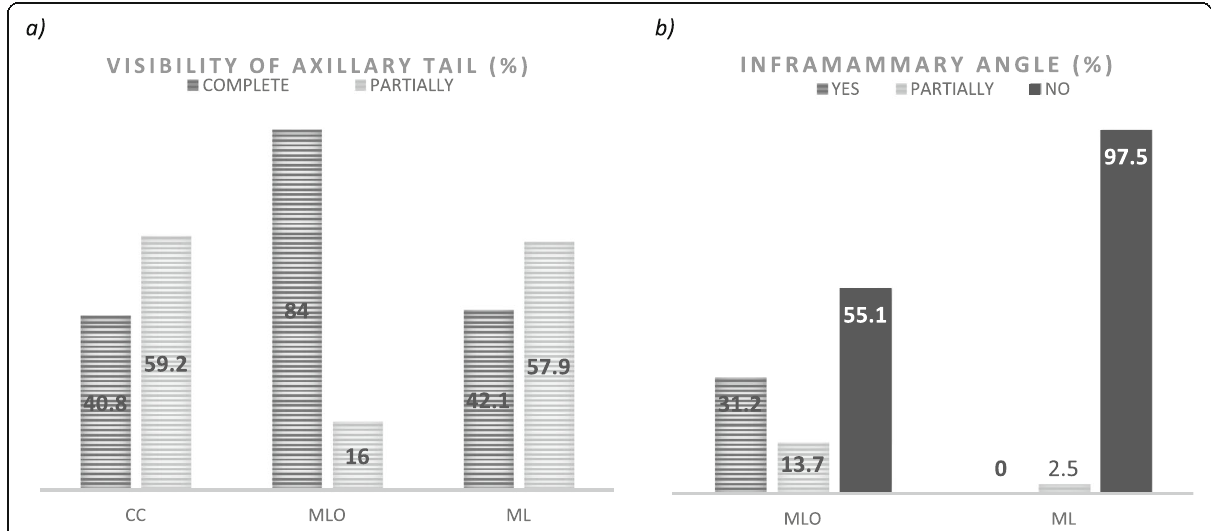
Fig. 4 a Visibility of axillary tail visibility in CC, craniocaudal; MLO, mediolateral oblique; and ML, mediolateral images; b visibility of inframammary angle in MLO and ML